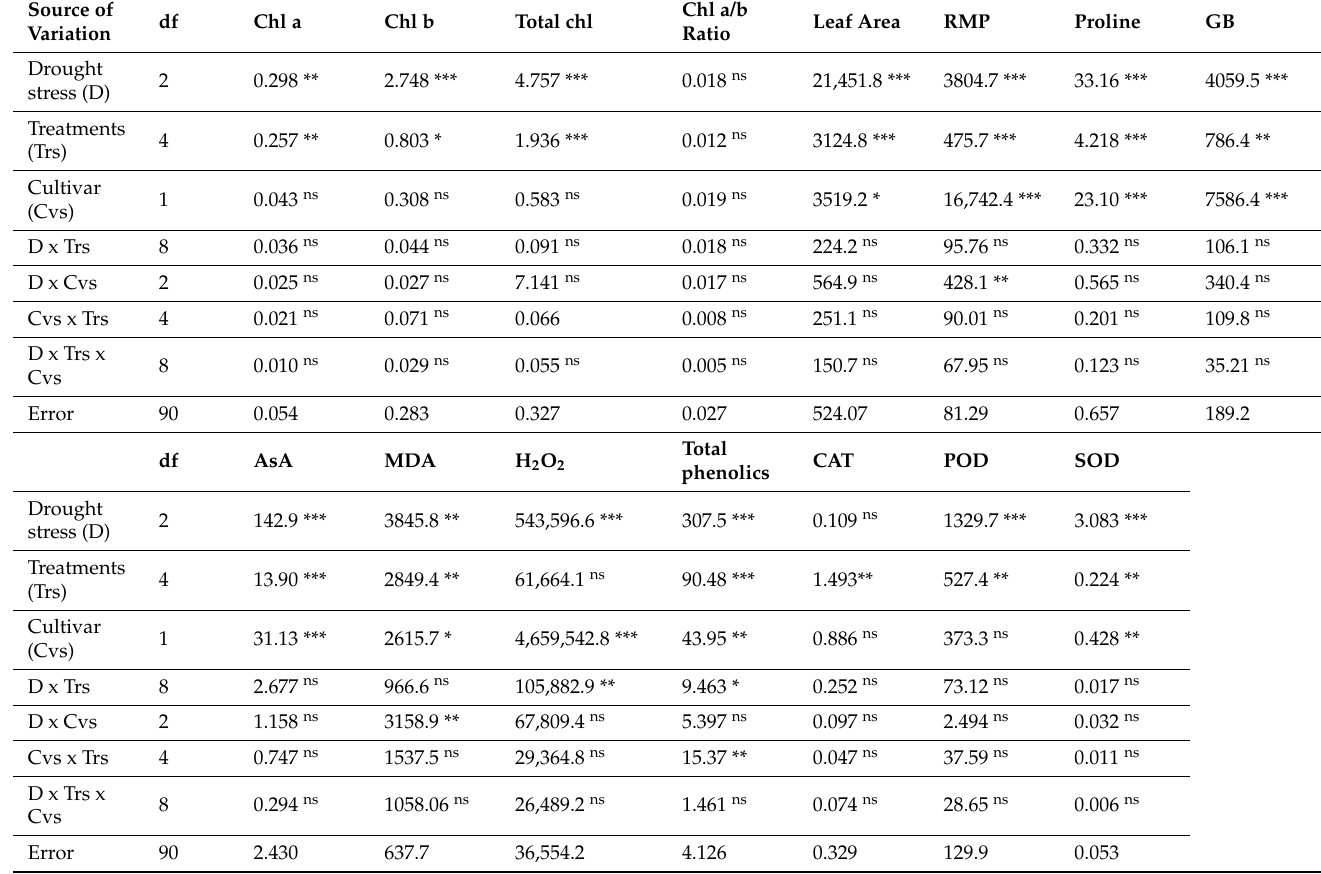
Table 2. Analyses of variance data for various physio-biochemical attributes of maize ( Zea mays L.) cultivars subjected to varying levels of sugar beet extract (SBE) and glycine betaine under water deficit